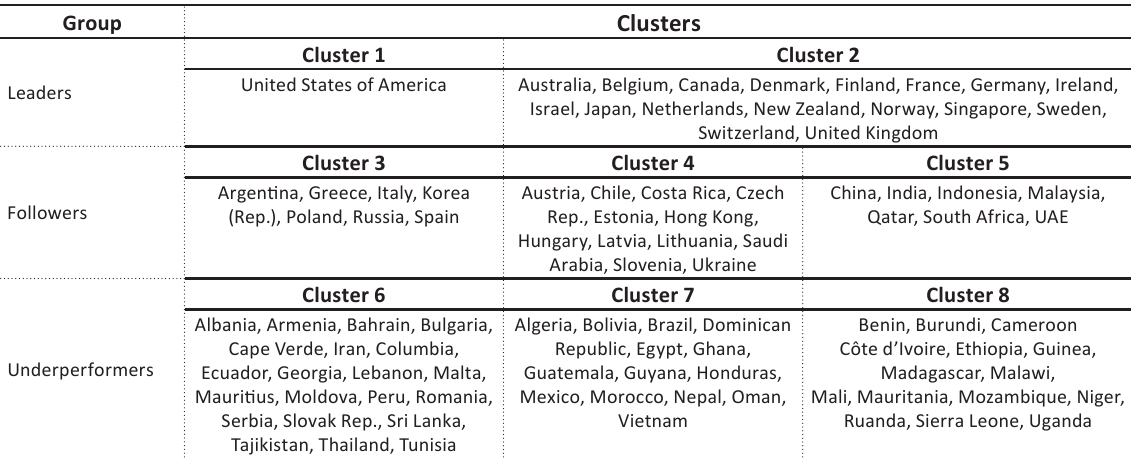
Table 2. Competitive positioning of the national higher education systems